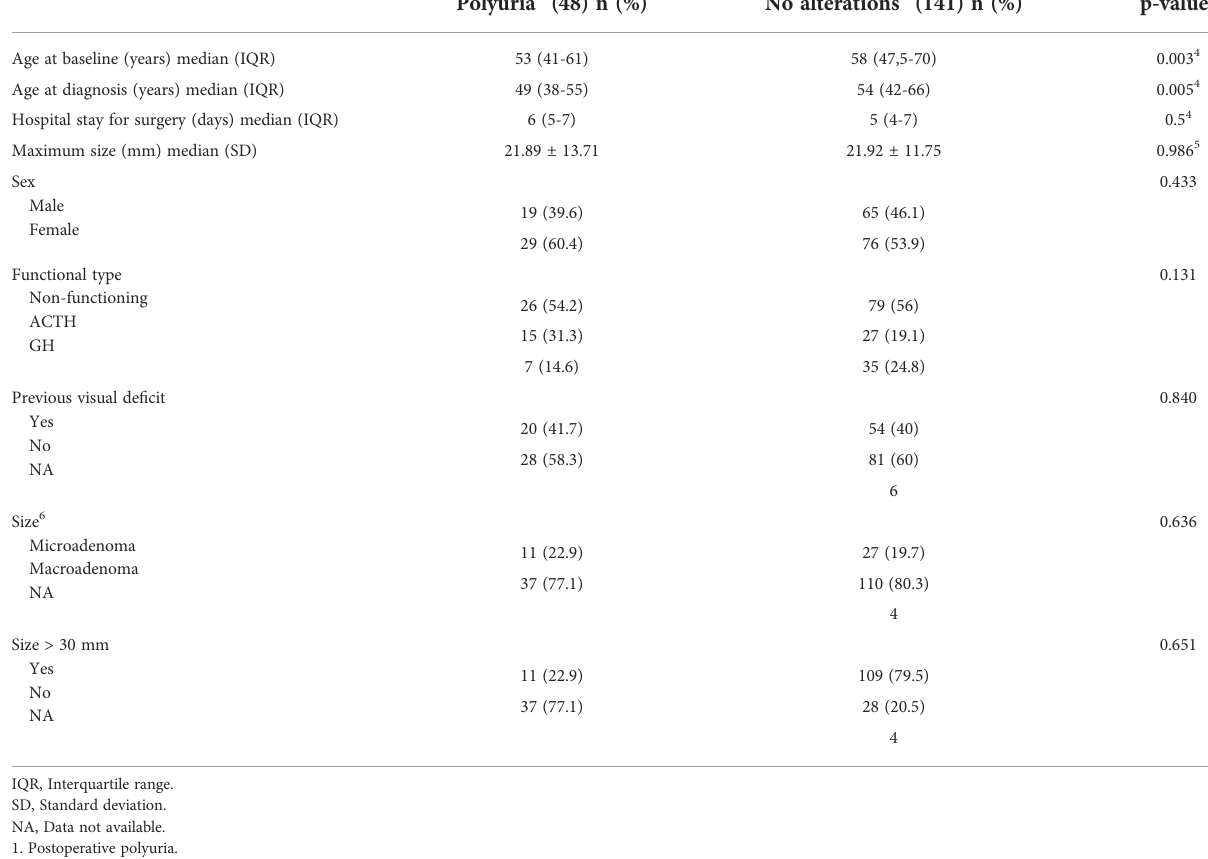
TABLE 2 Postoperative